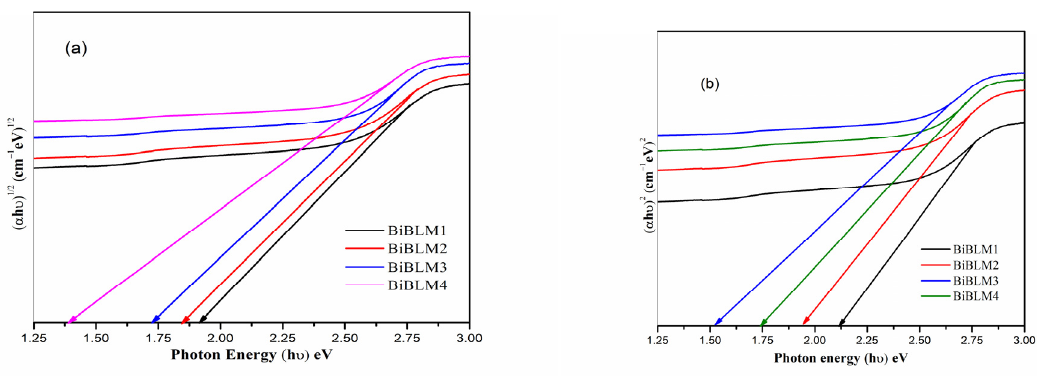
Figure 7. Tauc’s plots ( a ) Indirect bandgap ( b ) direct bandgap of BiBML glasses. Materials (amorphous), for instance, glasses incorporate a band stalking in the con- strained energy band gap, these values implicate the minimal defects and disorderliness in the glasses, and these are evaluated using the Urbach rule [45,46].